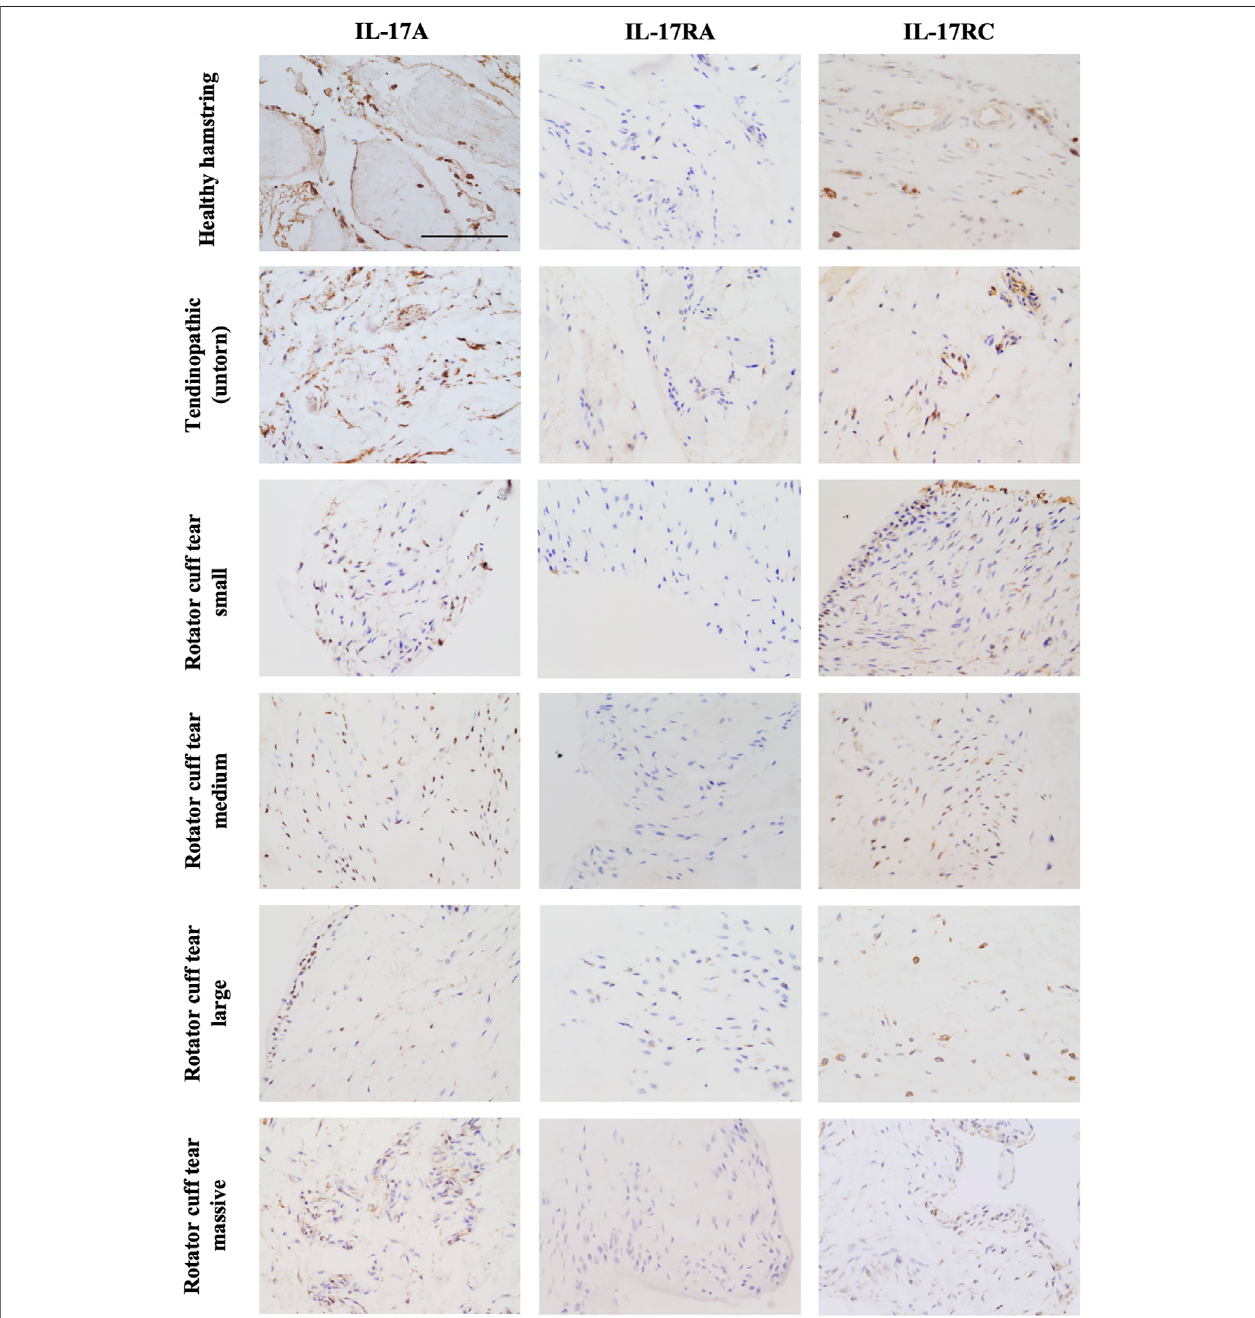
FIGURE1| RepresentativeimagesshowingproteinexpressionofIL-17AandIL-17receptorA(IL-17RA)andIL-17RCinhealthytendontissue(hamstringtendon), ordiseasedtendon tissuerangingfromtendinopathic(untorn)tosmall,medium,large,andmassiverotatorcufftears(supraspinatustendon).Antibodieswerevisualised with DAB (brown) and nuclei counterstained with haematoxylin (blue). Images were taken at 40x magni fi cation; scale bar (cid:1) 100 μ m.